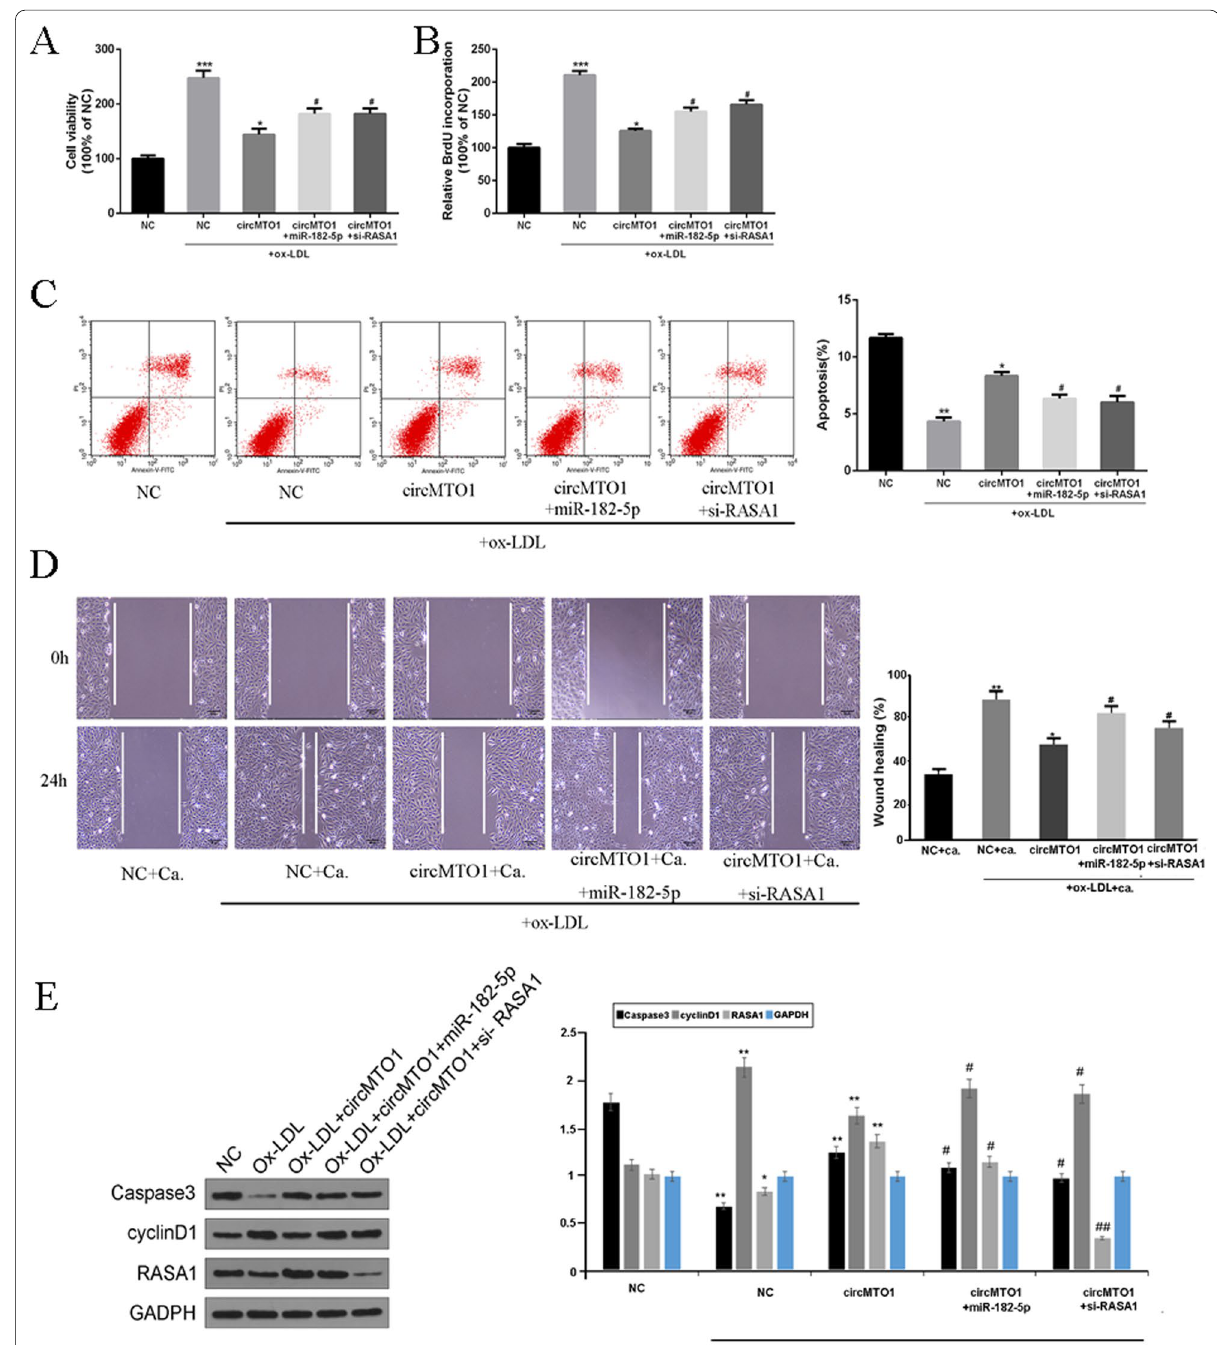
Fig. 5 Effect of miR-182-5p overexpression or RASA1 knockdown on circMTO1-induced proliferation, apoptosis and migration of VSMCs. A Viability of VSMCs co-transfected with circMTO1 vector and miR-182-5p mimic or si-RASA1. B Proliferation of VSMCs co-transfected with circMTO1 vector and miR-182-5p mimic or si-RASA1. C Apoptosis of VSMC co-transfected with circMTO1 vector and miR-182-5p mimic or si-RASA1. D Migration of VSMCs co-transfected with circMTO1 vector and miR-182-5p mimic or si-RASA1. * vs NC (OX-LDL) circMTO1(OX-LDL) capecitabine group. Ca. indicates the capecitabine. ** P < 0.01, #P < 0.05. E Western Blot results of capase3, cyclinD1, RASA1 + and GADPH in VSMCs co-transfected with circMTO1 vector and miR-182-5p mimic or si-RASA1. * vs NC group, # vs circMTO1 group. *** P < 0.001, ** P < 0.01, # P <